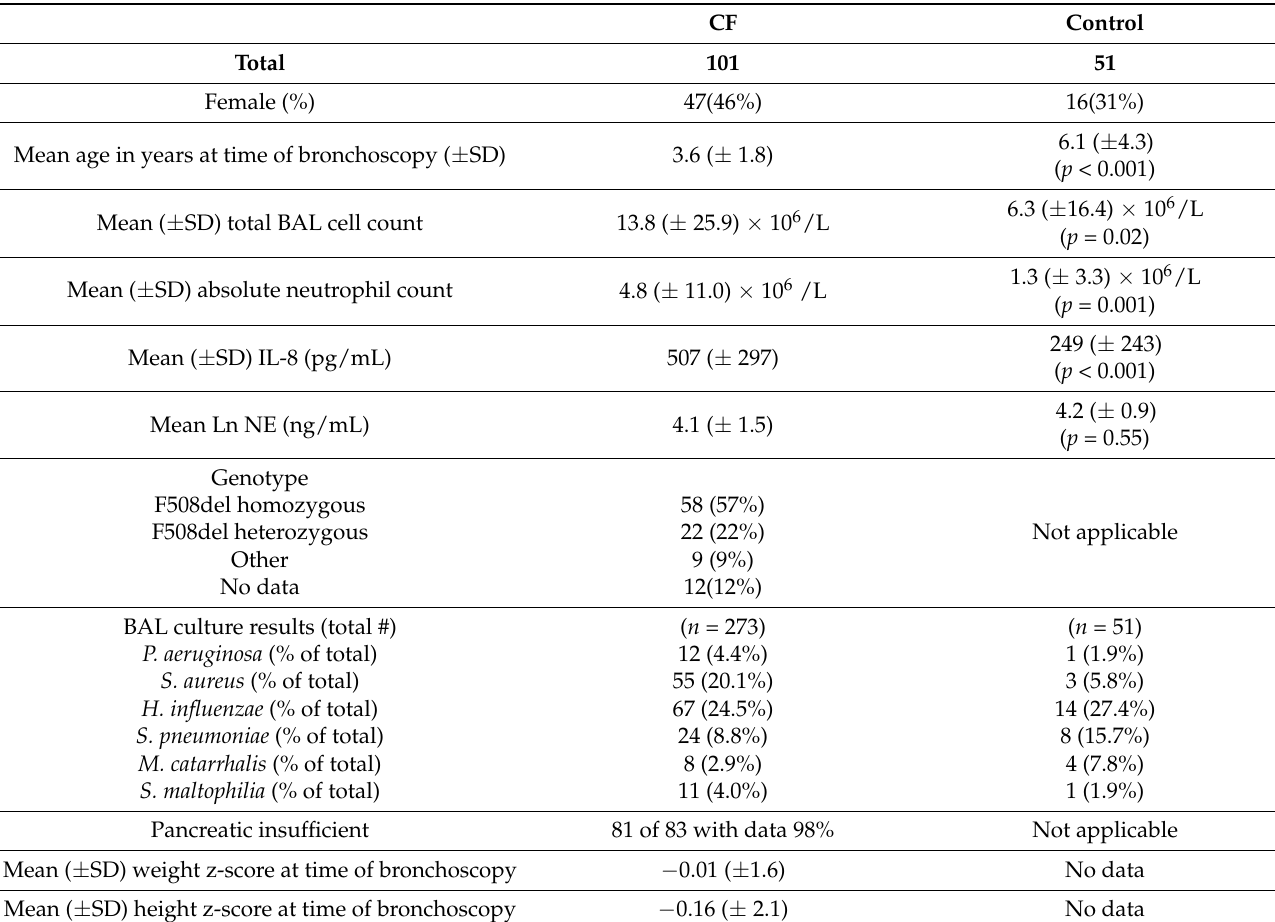
Table 1. Subject